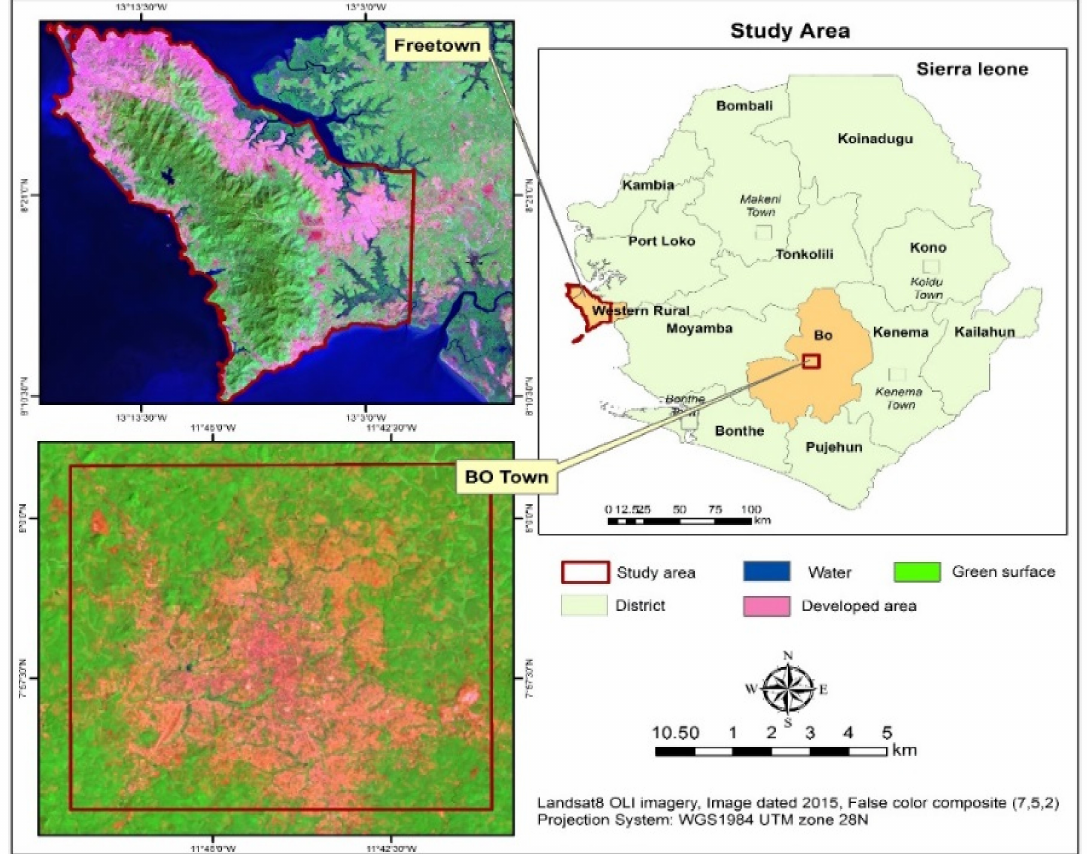
Figure 1. Location of Freetown and Bo town in Sierra Leone, West